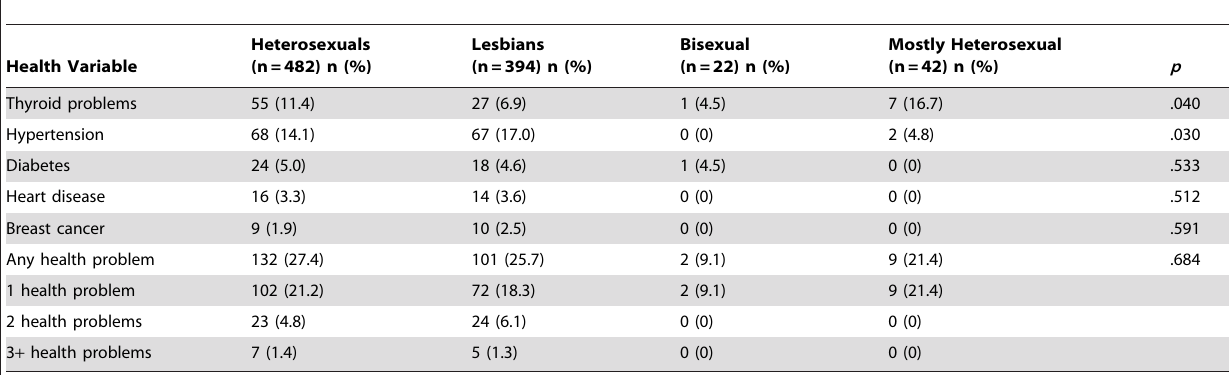
Table 2. Physical Health Problems Experienced by Heterosexual and Sexual Minority